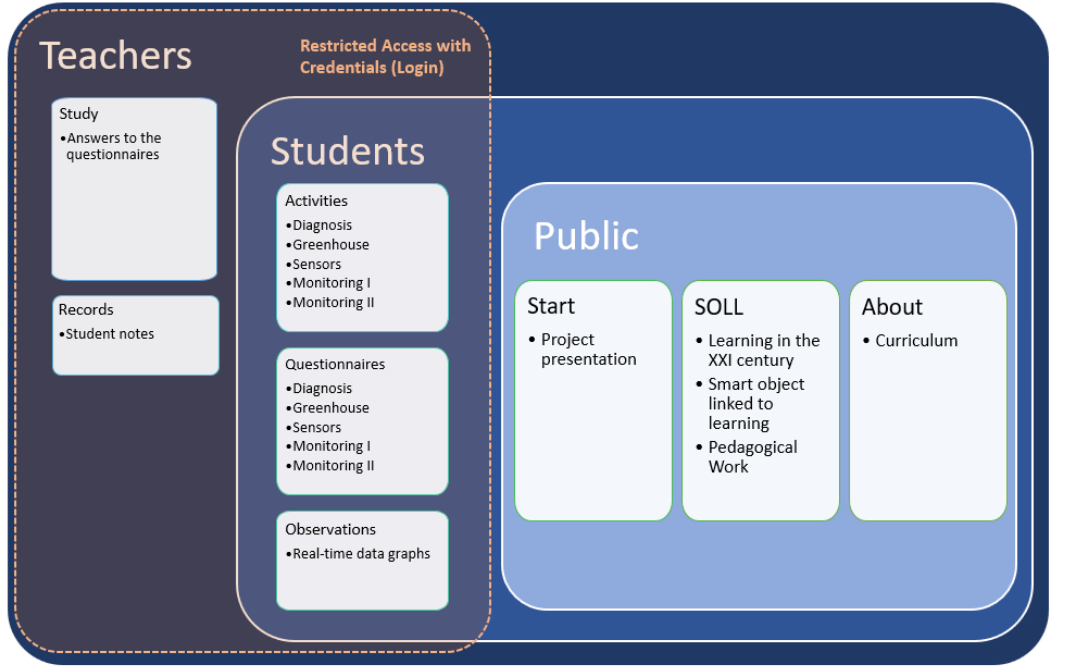
Figure 2. Map of the SOLL learning plataform, elaborated by the